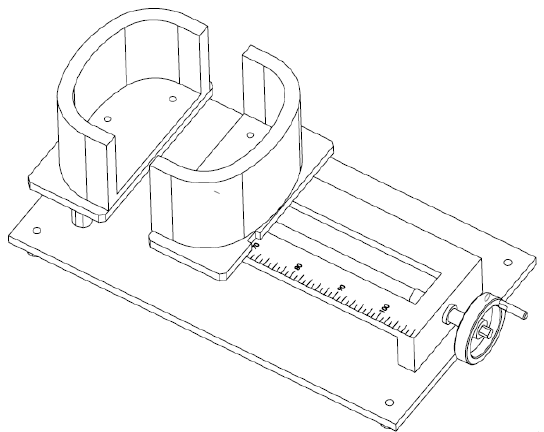
Figure 5. Illustration of the self-made apparatus for RIP performance